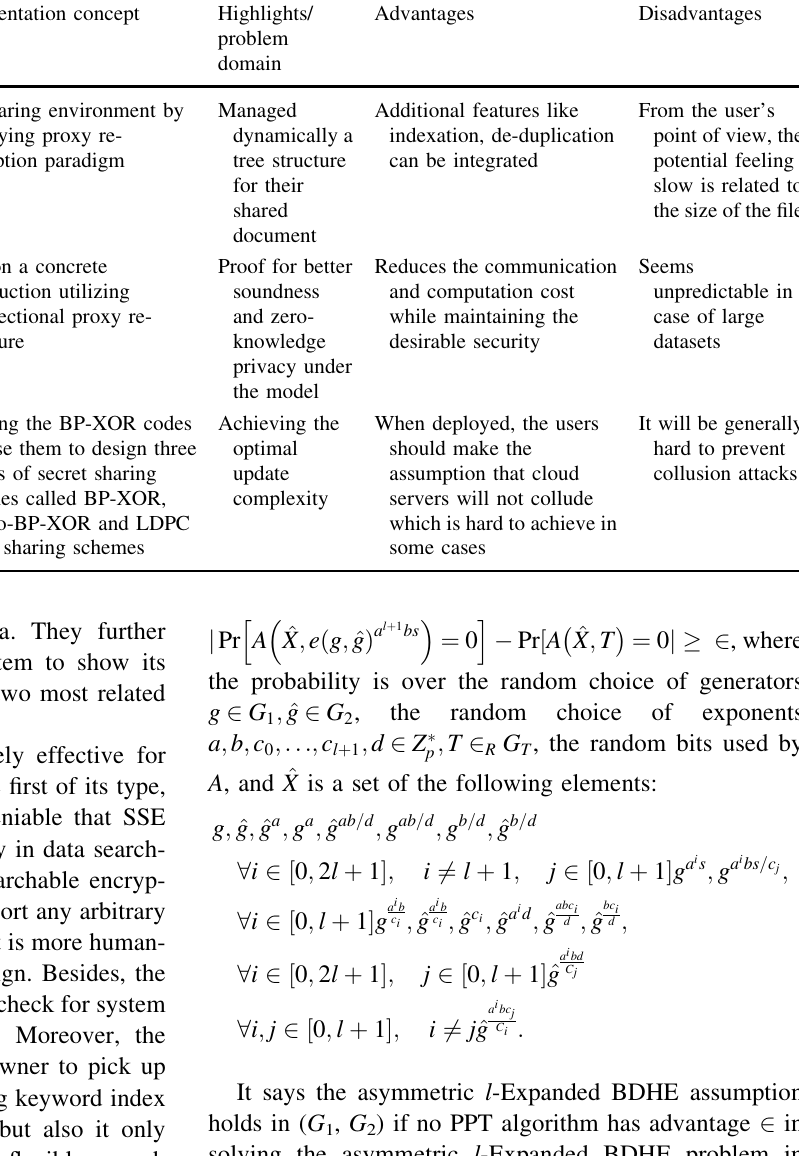
Table 1 Comparison of trust-based evaluation approaches Architecture